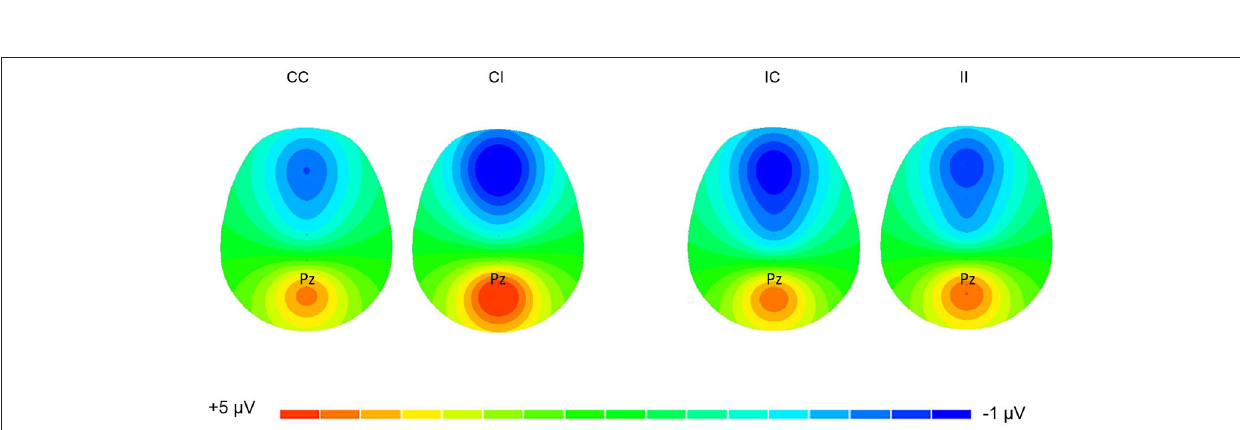
Frontiers in Human Neuroscience |